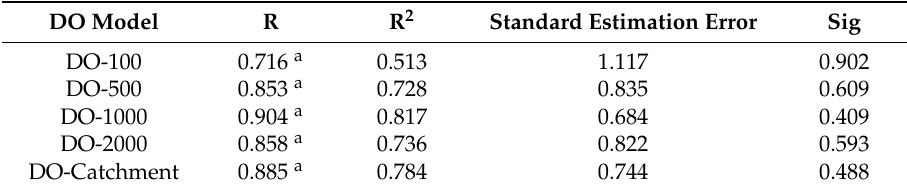
Table 7. The linear model general situation of